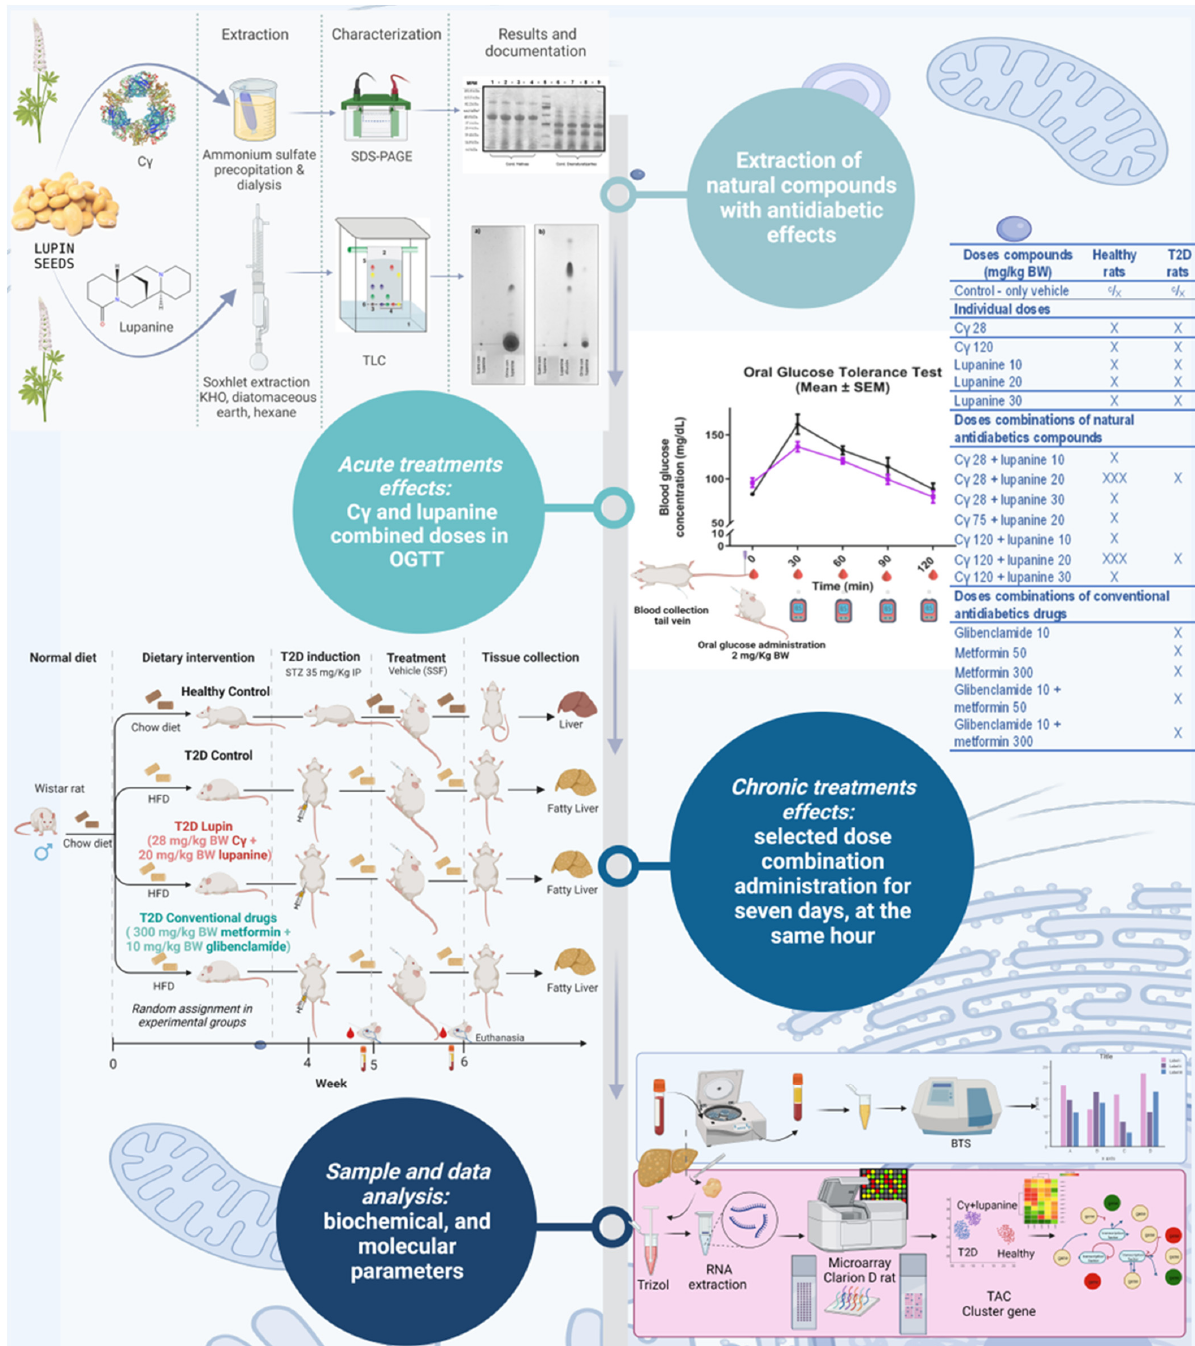
Figure 6. Study design.